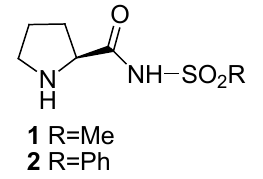
Figure 1. Sulphonimide catalysts.